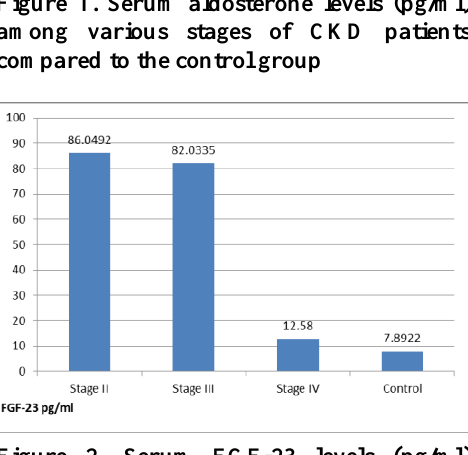
Figure 2. Serum FGF-23 levels (pg/ml) among various stages of CKD patients compared to the control group Correlation studies for studied parameters among various groups